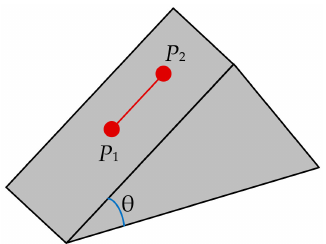
Figure 6. Elevation di ff erence on